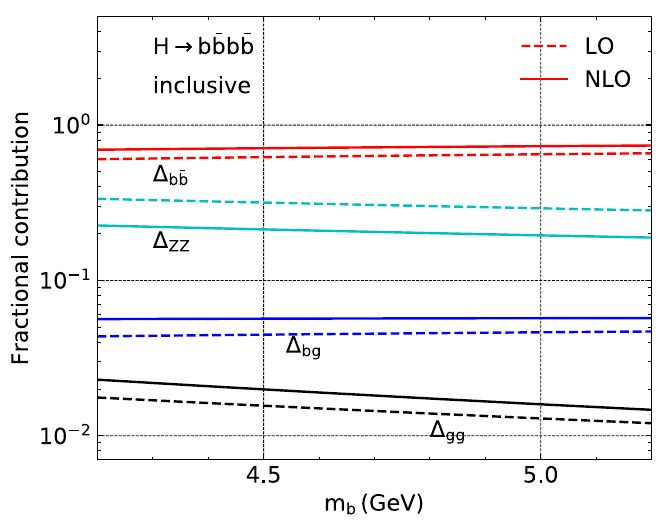
Figure 4 . Fractional contributions to partial decay width of the Higgs boson to four bottom quarks as a function of the bottom quark mass, at both LO and